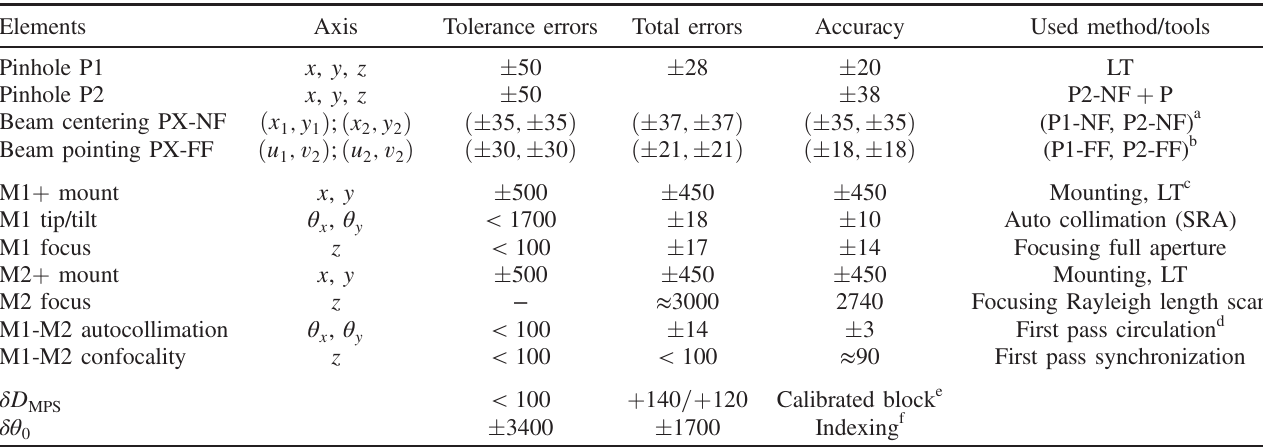
TABLE VII. Alignment budget error for elements of the LBC and accuracy of methods and tools used. All μ m and μ rad. Elements Axis Tolerance errors Total errors Accuracy Used method/tools Pinhole